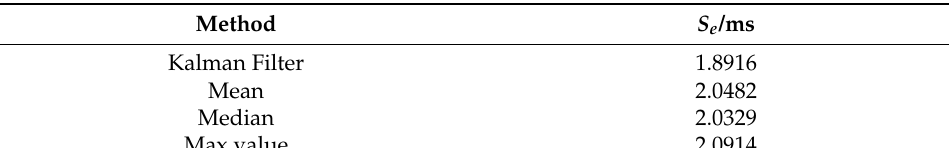
Table 2. RMSE of methods.